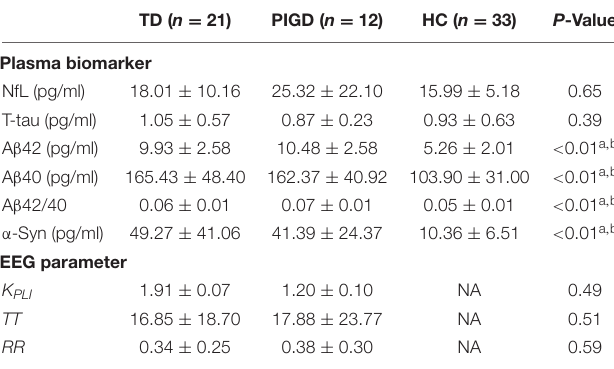
TABLE 1 | Demographic and clinical characteristics of study participants. Characteristics